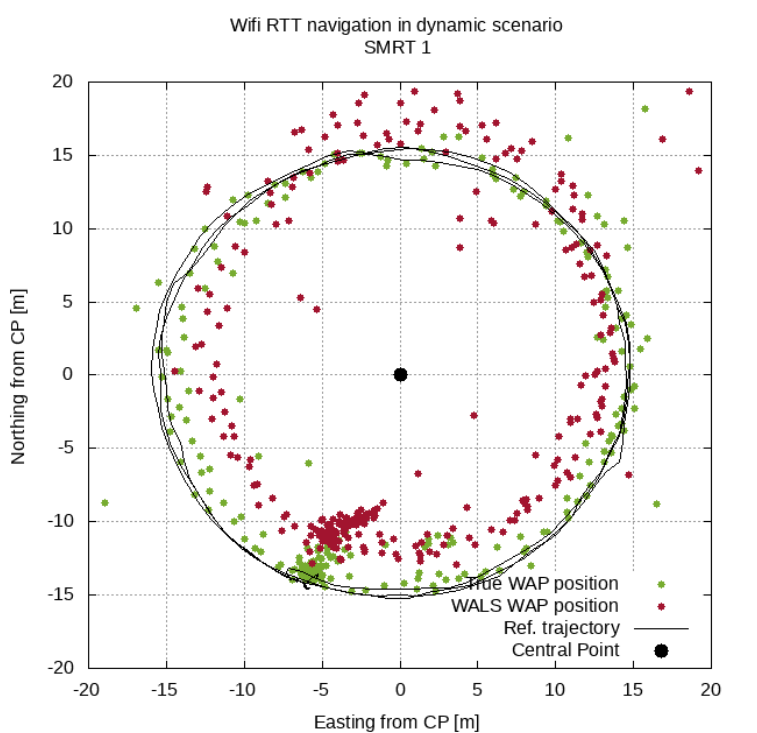
Figure 5. The results of the WiFi positioning in a dynamic environment using WAP positions obtained from a true reference or from the proposed methodology